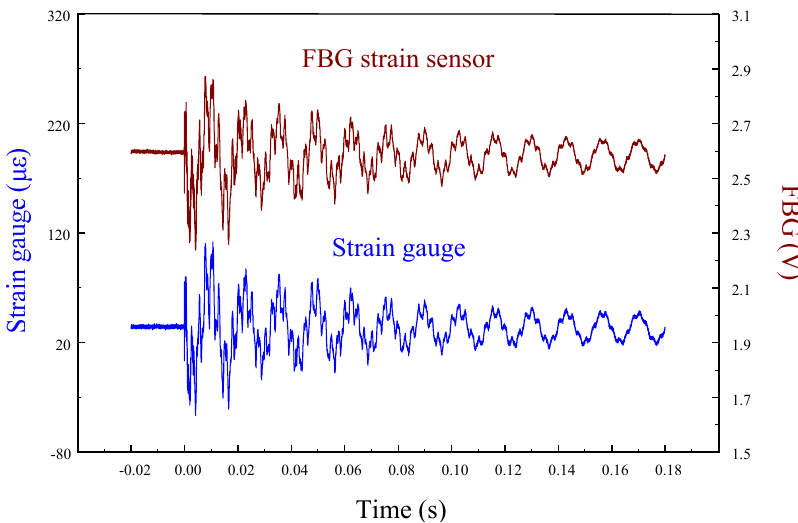
Figure 7. Transient strain responses of the smart cantilever beam subjected to the impact loading by a steel ball.